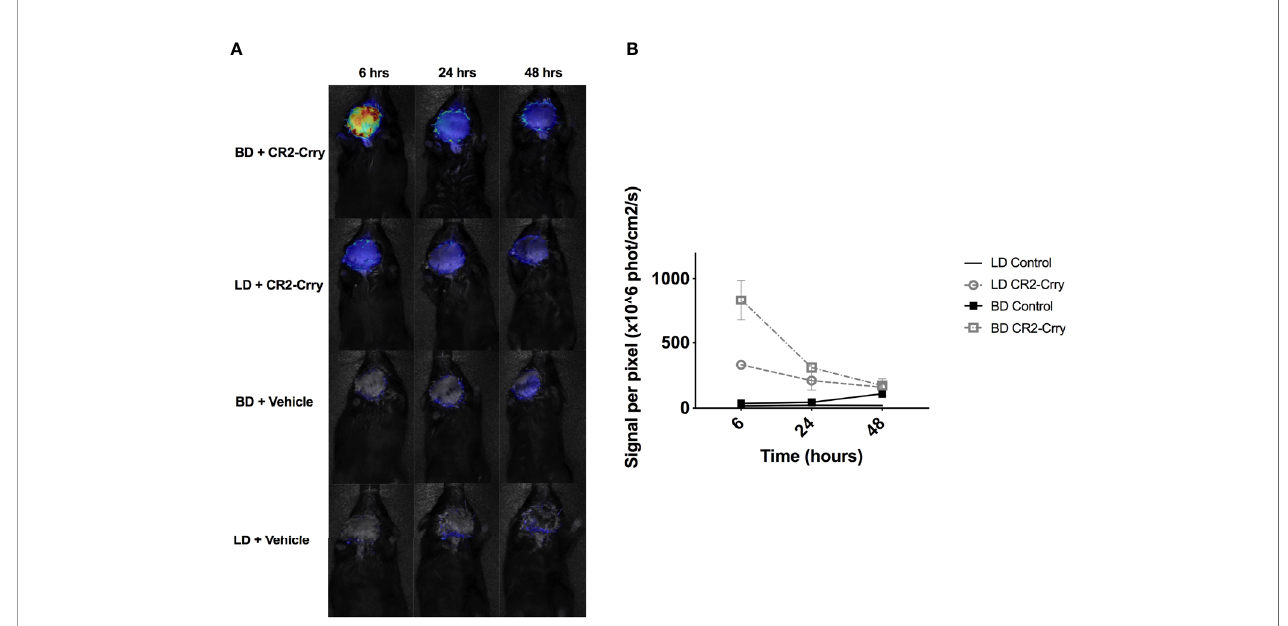
FIGURE 3 | CR2-Crry is retained post-transplantation in VCAs from BD donors. LD and BD VCAs were perfused with UW solution augmented with fl uorescently labeled CR2-Crry before VCA procurement. After 6 hrs of cold storage, grafts were heterotopically transplanted into C57BL/6 recipients and fl uorescence imaging of whole animals performed at 6, 24, and 48 hrs post-Tx to test for CR2-Crry retention in grafts. (A) Recipient mouse photos overlaid with heatmaps of CR2-Crry fl uorescence intensity at different timepoints and (B) Respective quanti fi cation of signal intensity. Multiple t-test, one per timepoint, were performed